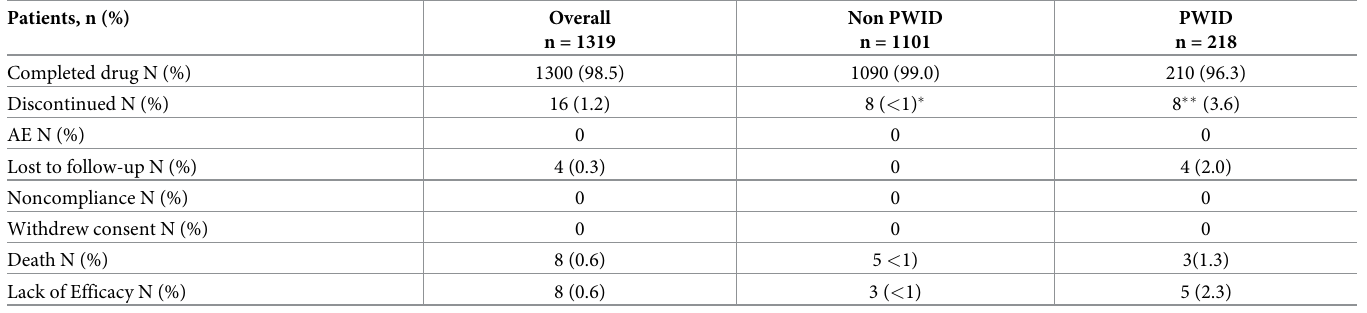
Table 3. Study disposition in general population and PWID.